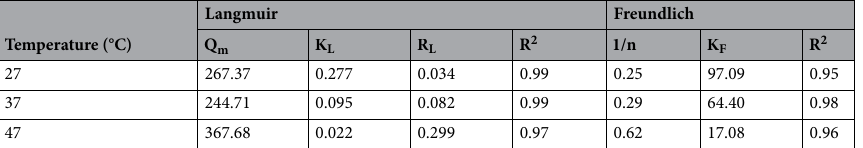
Table 2. Langmuir and Freundlich constants of MB adsorption on BC-based CH at different temperatures. Q m : mg/g, K L : l/mg, K F : mg/g, R 2 : the correlation coefficient values being expressed in model fitting process.